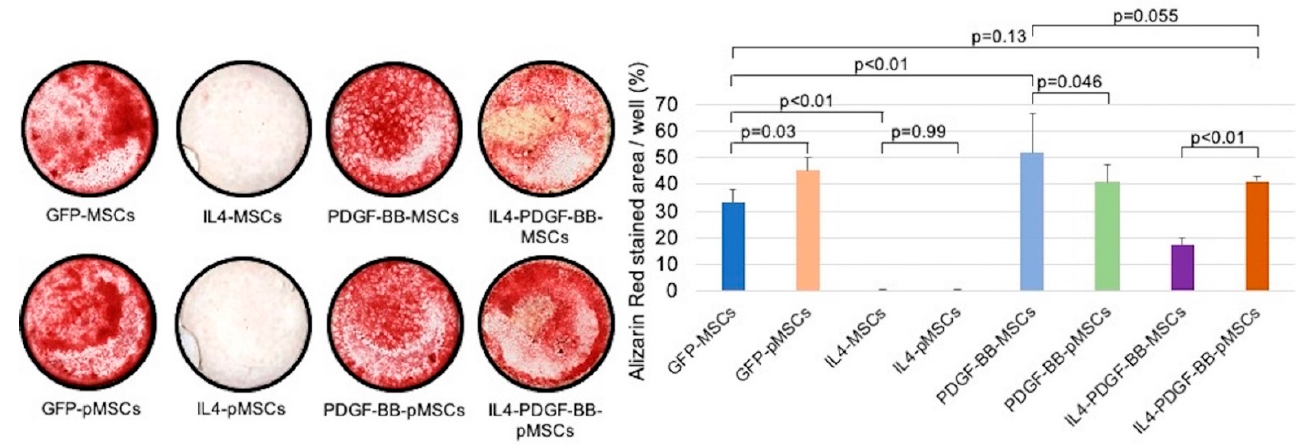
Figure 6. Alizarin red-staining in all eight groups 4 weeks after seeding. The percentages of stained area in the GFP-MSC, GFP-pMSC, IL4-MSC, IL4-pMSC, PDGF-BB-MSC, PDGF-BB-pMSC, IL4-PDGF-BB-MSC, and IL4-PDGF-BB-pMSC groups were 33.1 ± 4.7%, 45.1 ± 4.9%, 0.64 ± 0.08%, 0.58 ± 0.03%, 51.7 ± 14.5%, 40.7 ± 6.7%, 17.3 ± 2.5%, and 41.2 ± 1.7%, respectively. Table 2. The summary of the results.